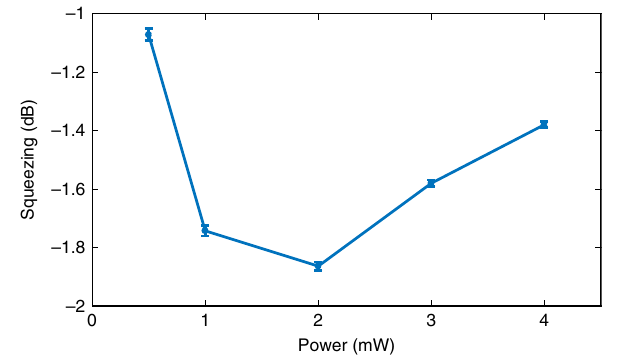
Fig. 7 Degree of squeezing versus probe power. We observe a squeezing optimum as 2 mW. ν L = 1.3 kHz. Error bars show ±1 σ uncertainty in the variance, originating in the uncertainty of the atomic number.